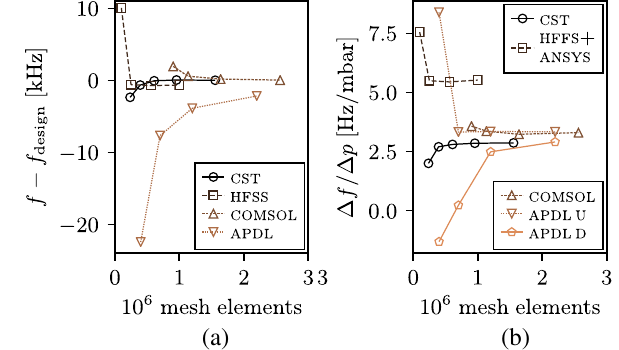
FIG. 17. (a) Quarter of the transverse cavity cross section with FIG. 18. Convergence study based on mesh refinement. (a) The the groove radius r . (b) The frequency versus pressure sensitivity g frequency error of rf eigenmode simulation by means of the as a function of the groove radius calculated in CST . A quasistatic undeformed geometry. (b) The frequency versus pressure sensi- pressure difference of 1 bar is applied at the outer cavity wall. tivity derived from a quasistatic pressure difference of 1 bar at the Gravity is not considered. outer cavity wall where both flanges are fixed and gravity is not present. The two methods to apply an rf simulation for a deformed geometry in APDL are denoted as UPGEOM ( U ) and DVMORPH ( D ).